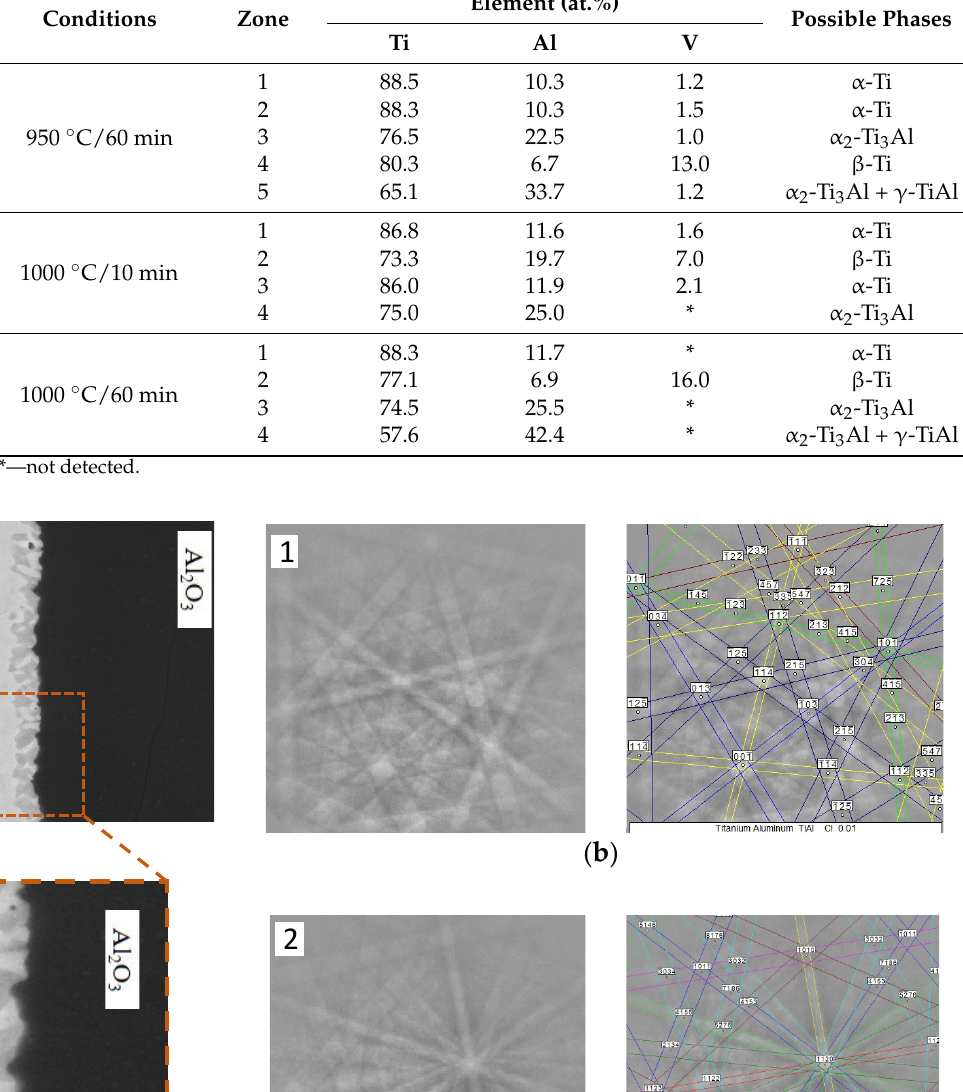
Table 1. Chemical composition obtained by EDS of the zones in Figure 6.